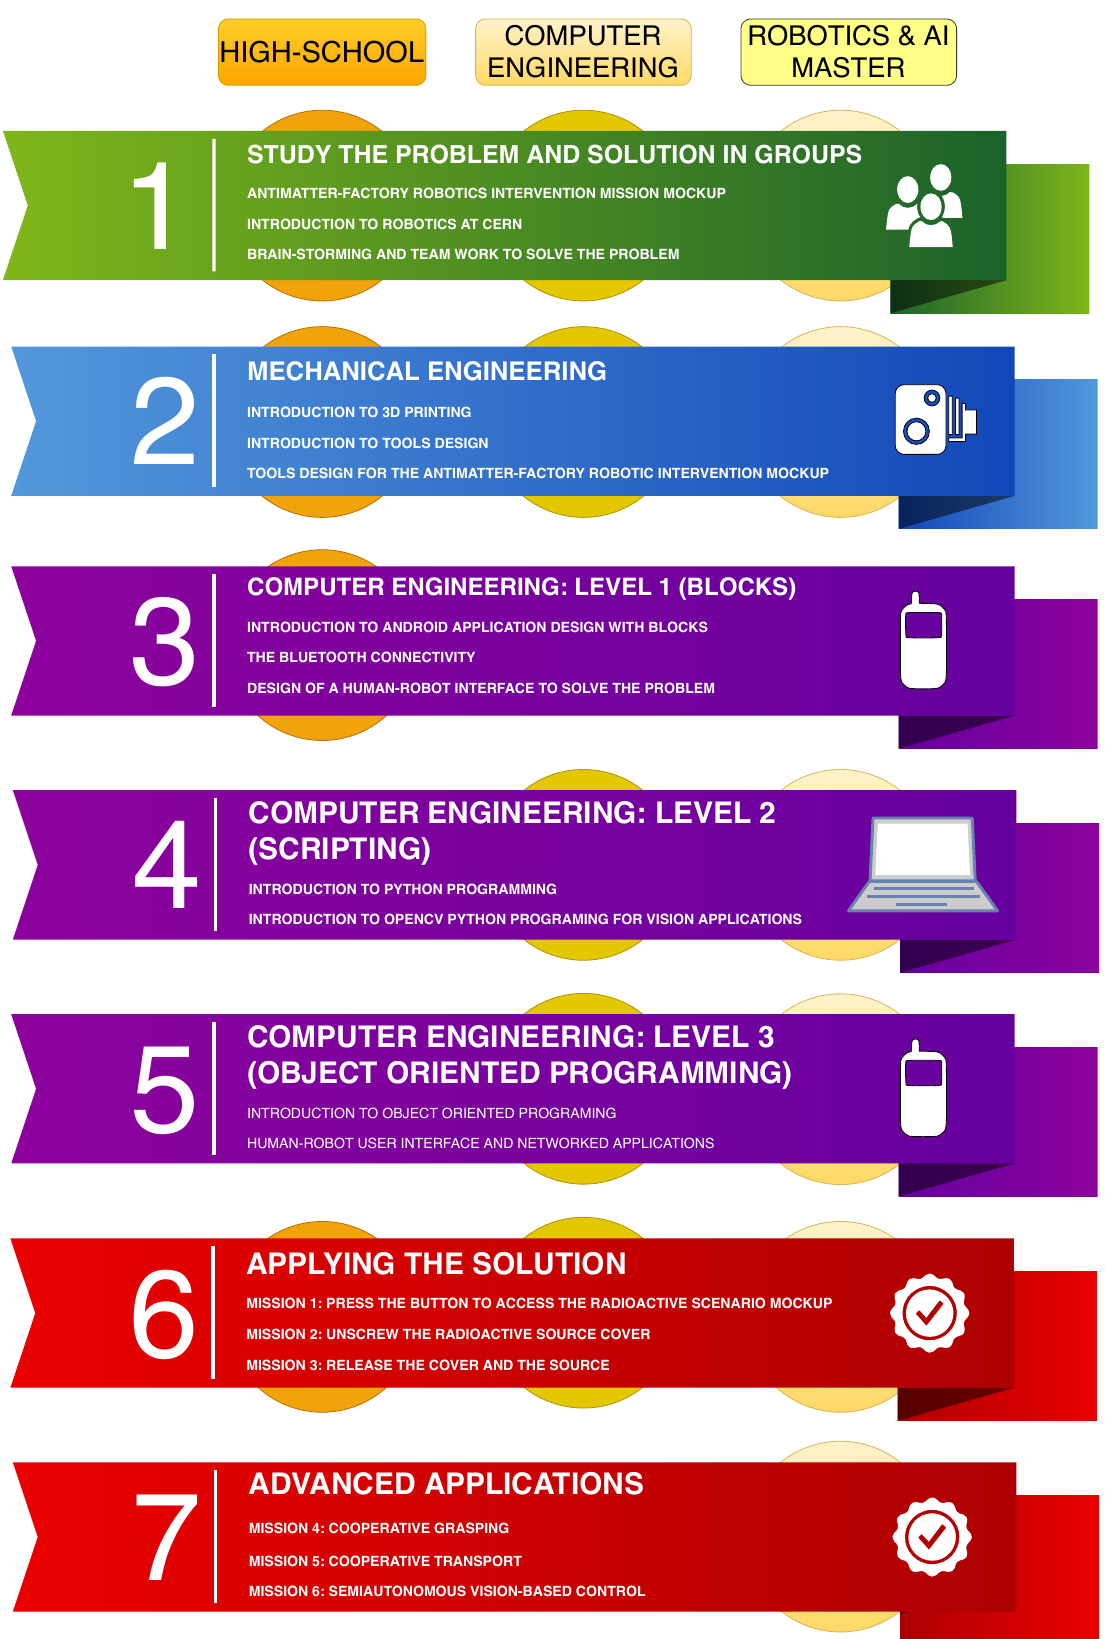
Figure 1. Learning activities using the MiniCernbot